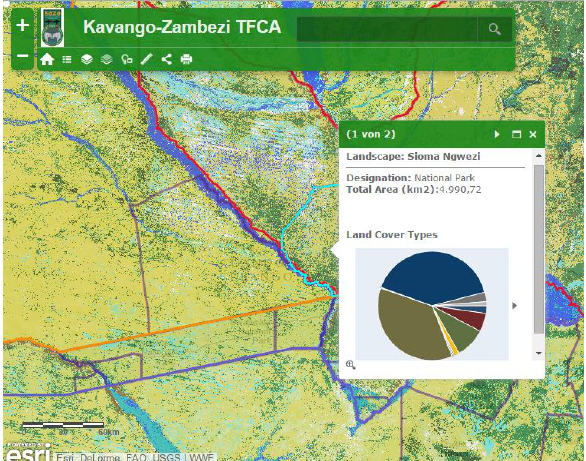
Figure 3. the KAZA web map summarized land cover and other data in a series of monitoring